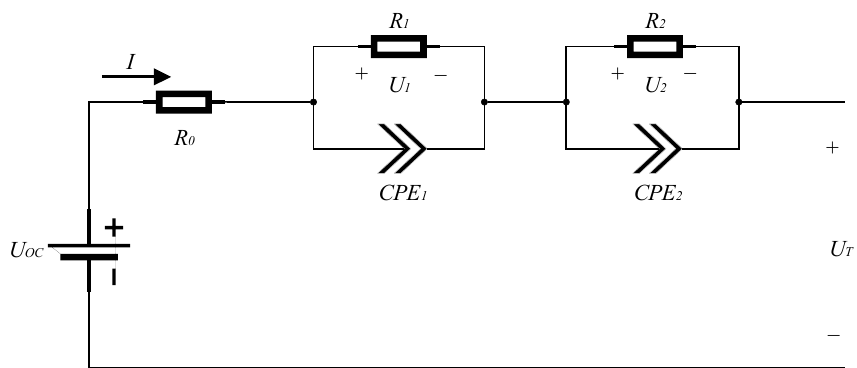
Figure 1. The fractional order model with two CPEs of the lithium-ion battery. The structure is similar to that of the IOM, except for the use of the constant phase element. R 0 is the ohmic internal resistance; U oc represents the open-circuit voltage (OCV); U T denotes the terminal voltage; I is the operating current; the first loop formed by R 1 and